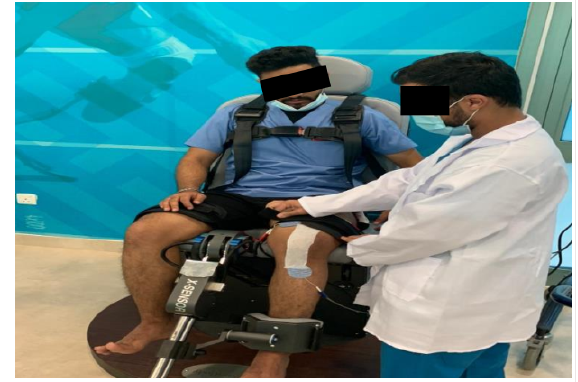
Figure 4. Application of nonrigid hypoallergenic tape (for placebo